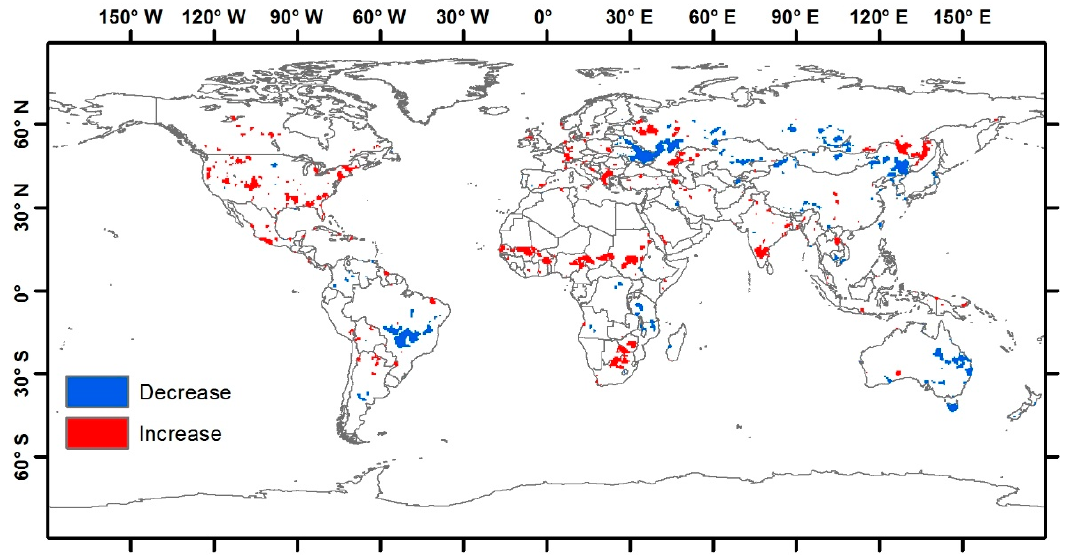
Figure 9. Significant trends of BA (with a confidence level of 95%) in the short-term series from 1982 to 2000 (FireCCILT11).